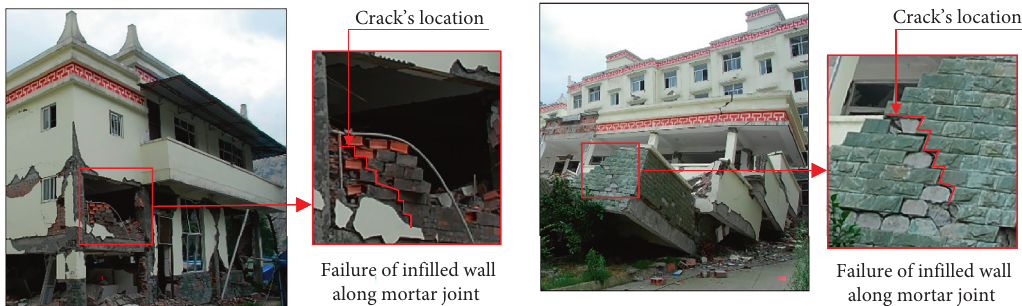
Figure 8: Seismic damage characteristics of infilled wall (the picture from author Dai